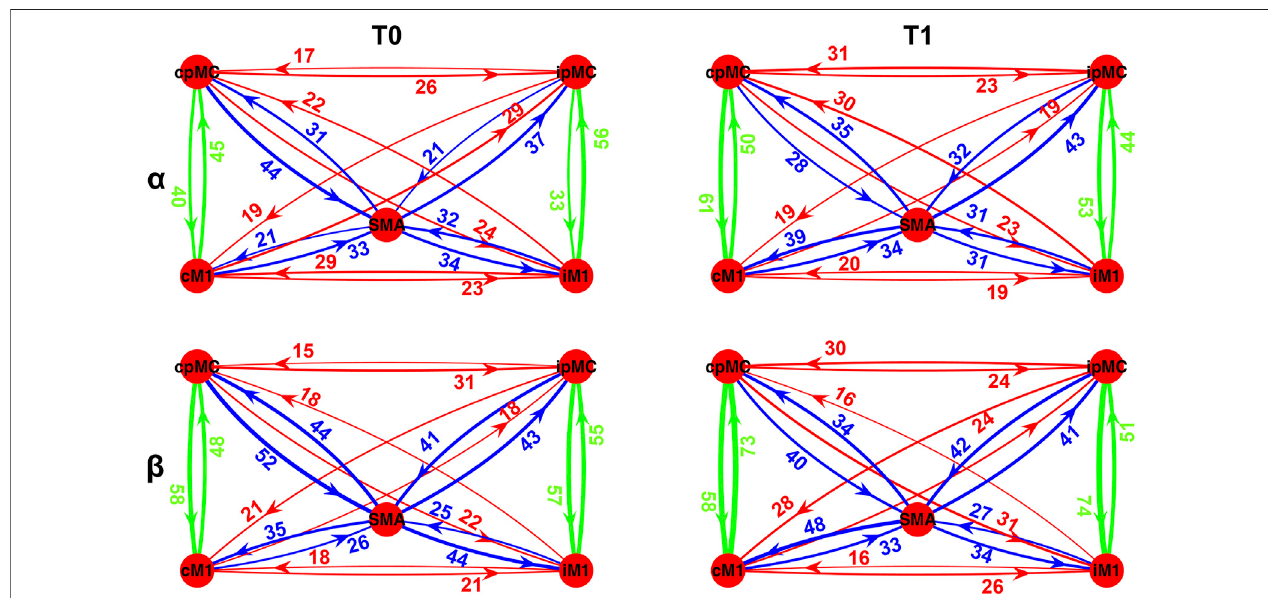
FIGURE 4 | Population ’ s subject-weighted-topographic connectivity maps in α (top panel) and β (bottom panel) frequency bands, at T0 (left column) and T1 (right column). Weights represent the percentage of subjects for which signi fi cant arrow with respect to its surrogate was detected, weighted by ICW. Green arrows: intra- hemispheric connections; red arrows: inter-hemispheric connections; blue arrows: SMA connections.